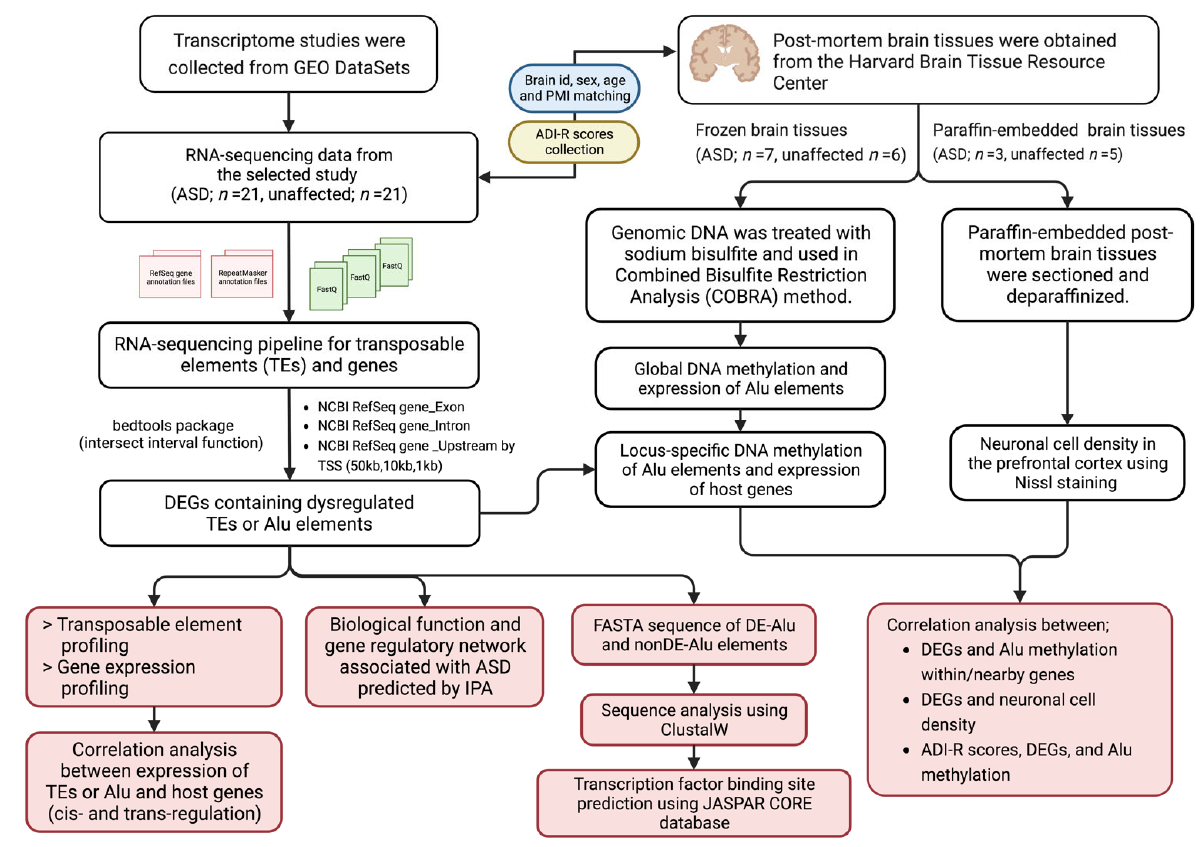
Figure 13. Experimental workflow (cid:1) of this study created with BioRender.com (accessed on 19 March 2023). 19 March